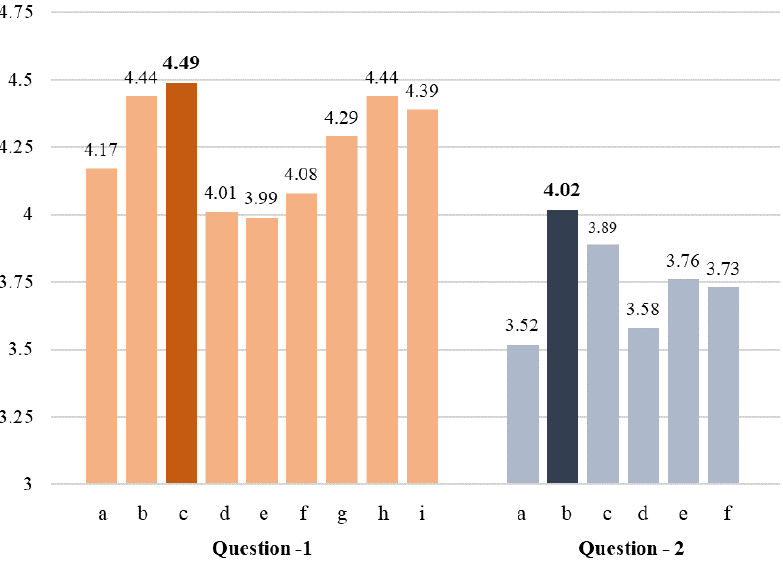
Figure 8. Weighted averages for responses on Questions 1 and 2.